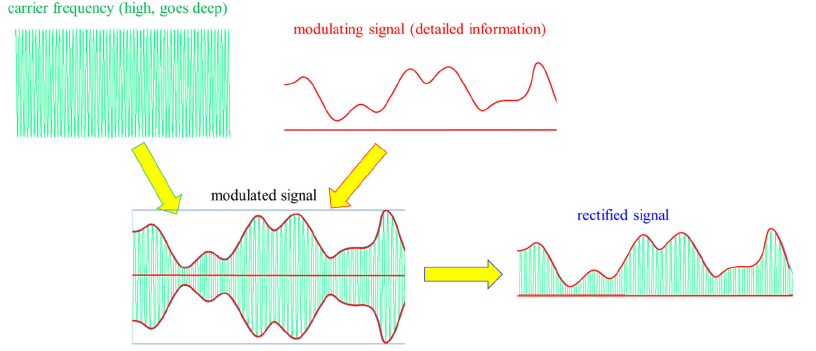
Figure 7. The modulation process compromises between the contradictory high- and low-frequency